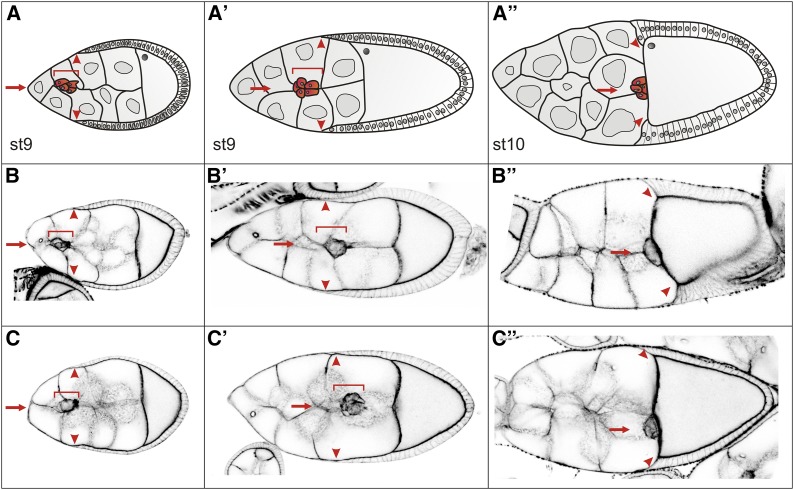
Border cell migration. (A-A’’) Sketch of border cell migration at stages 9 to 10 during Drosophila oogenesis. Early in stage 9, a cluster of border cells dispatches from the anterior tip of the follicle (A, red arrow), to migrate in between the large, polyploid nurse cells (A’) to finally reach the anterior of the oocyte in stage 10 (A’’). At the same time, the columnar follicle cells retract posteriorly; they are a useful marker for orderly migration (read arrowheads). Border cells are depicted in red, and highlighted by a red frame and a red arrow. (B-C’’) Cell outlines were visualized with phalloidin staining (black). Confocal images taken from the respective stages of control (B-B’’) and PKDcl4 mutant females (C-C’’) are shown inverse for better visibility. Border cells are marked by red frame and arrow; columnar follicle cell margins by read arrowheads, respectively, as in (A-A’’). The migratory behavior of border cells appears not different between the two genotypes.